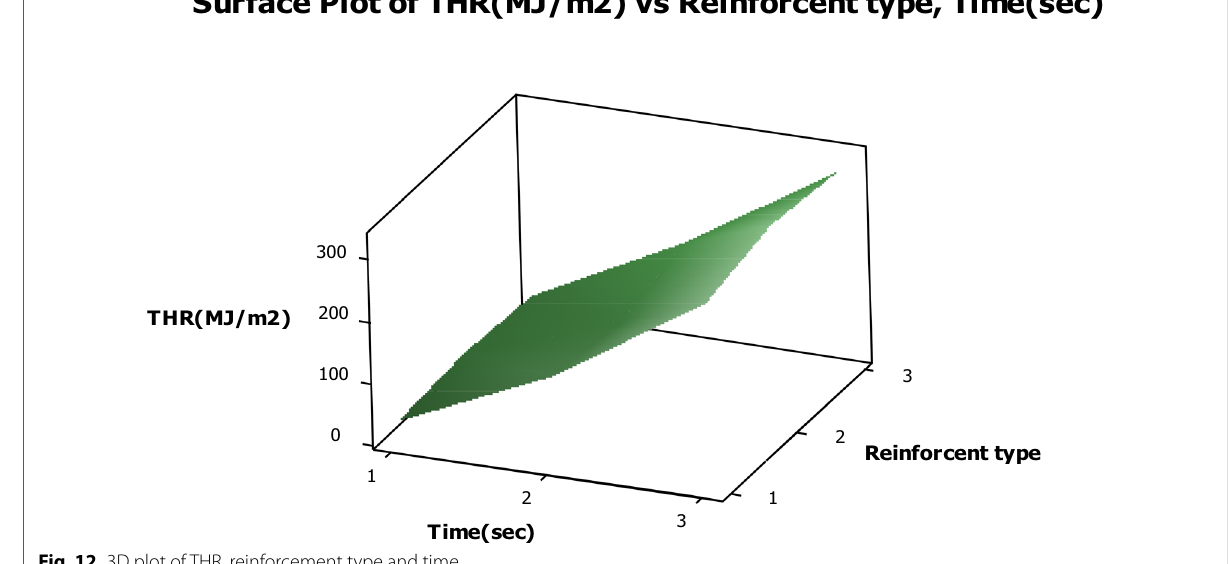
Fig. 12 3D plot of THR, reinforcement type and time